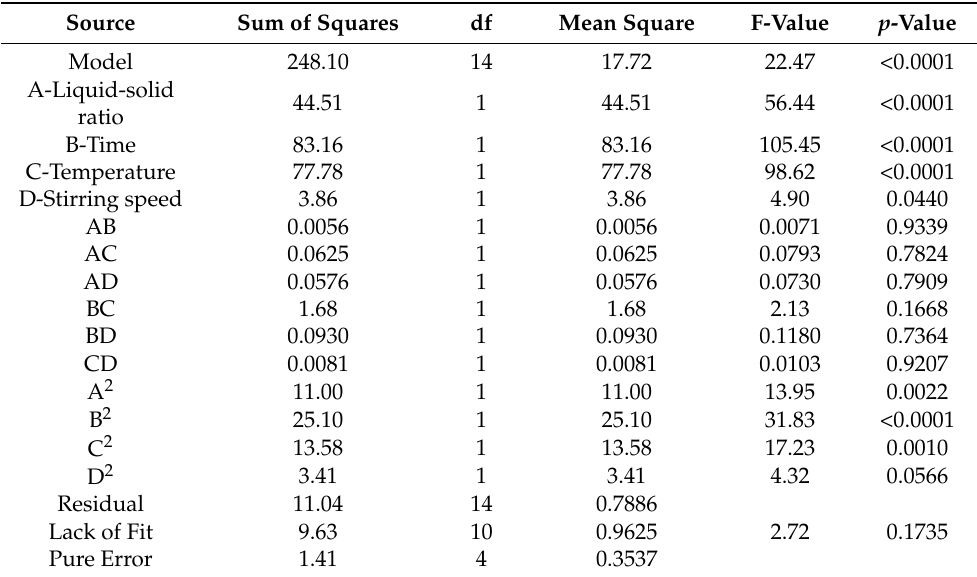
Table 4. Variance analysis of zinc leaching efficiency model.